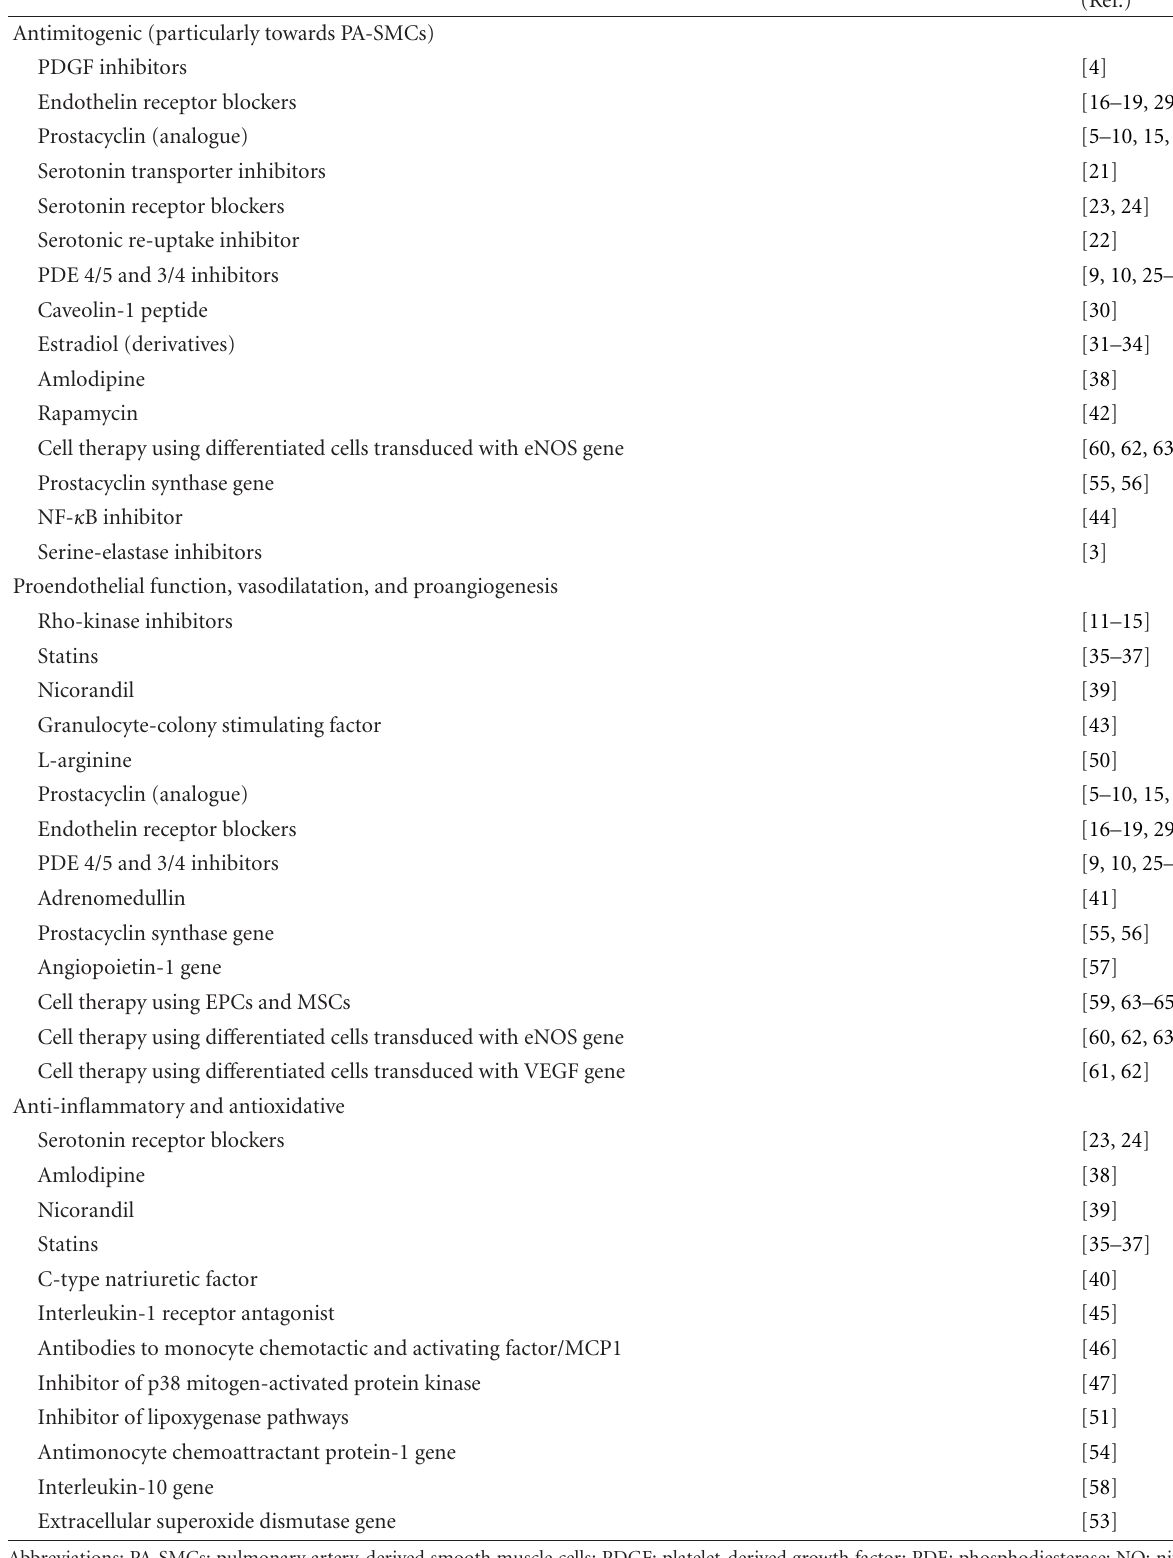
Table 1: Classification of published therapies of experimental pulmonary hypertension.